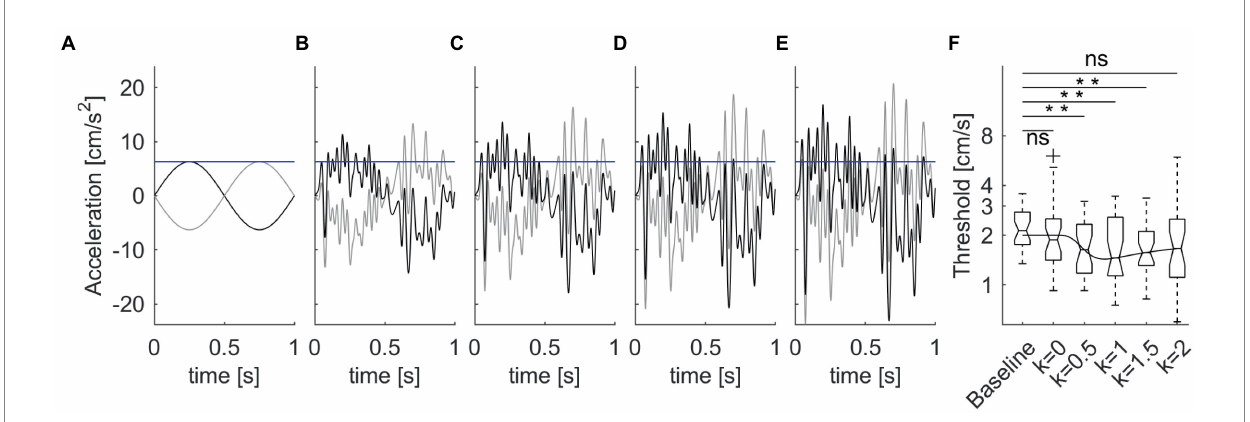
FIGURE 5 Enhancement of vestibular motion discrimination by stochastic whole-body perturbations. Sitting participants reported the perceived direction of antero-posterior 1 Hz sinusoidal motions. The amplitude of the stimulus was adjusted based on an adaptive staircase. (A) . Unperturbed stimuli in the forward (thick lines) and backward (thin lines) directions at baseline threshold (blue horizontal line) for a typical subject. (B–E) Perturbed stimuli with increasing noise amplitude [ k = 0.5–2 in Equation 2, from panels (B–E) ]. (F) Box-and-whisker plots of motion discrimination thresholds at population level ( N = 30 participants). Overlaid line is the best fit of the population data with Equation 9 of stochastic resonance. Data from La Scaleia et al.